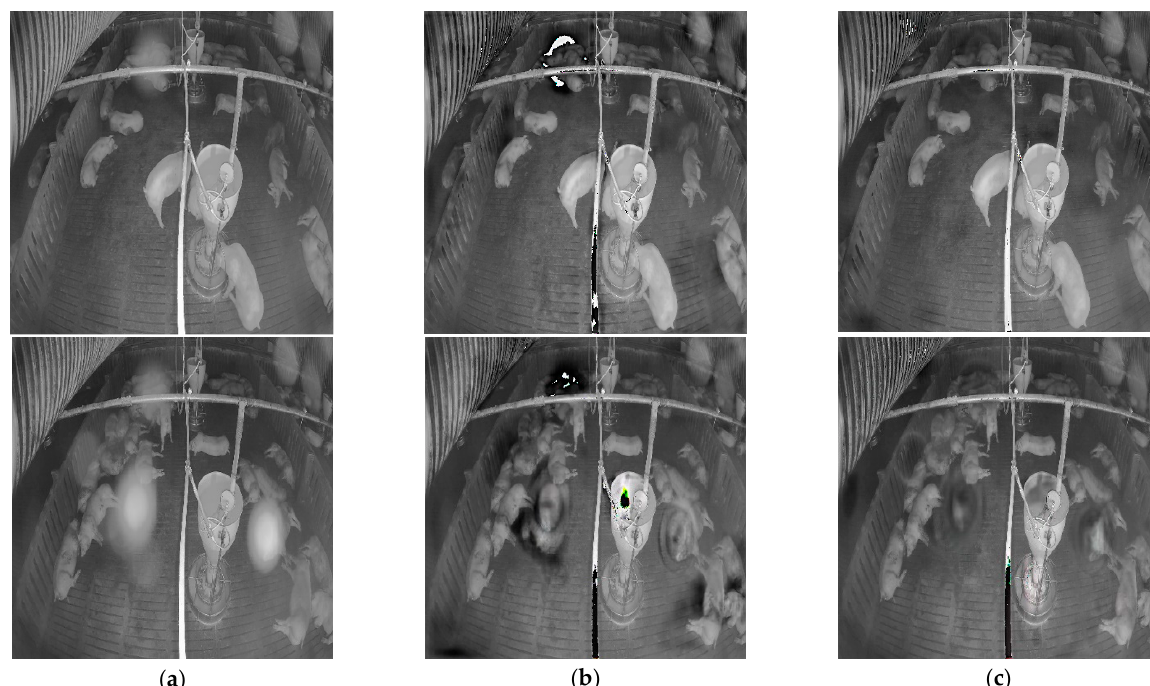
Figure 11. Denoised image produced by the model with and without the attention model on real ‐ noise image: ( a ) real ‐ noise image; ( b ) denoised image without attention module; ( c ) denoised image with attention module.